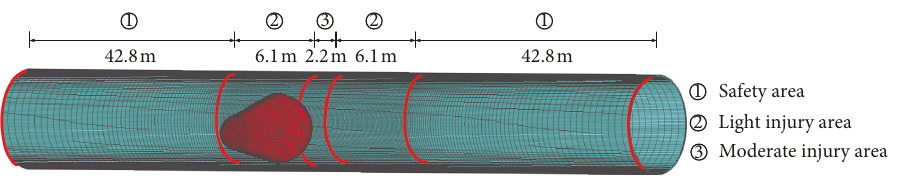
Figure 13: Division of physical injury along the tunnel.